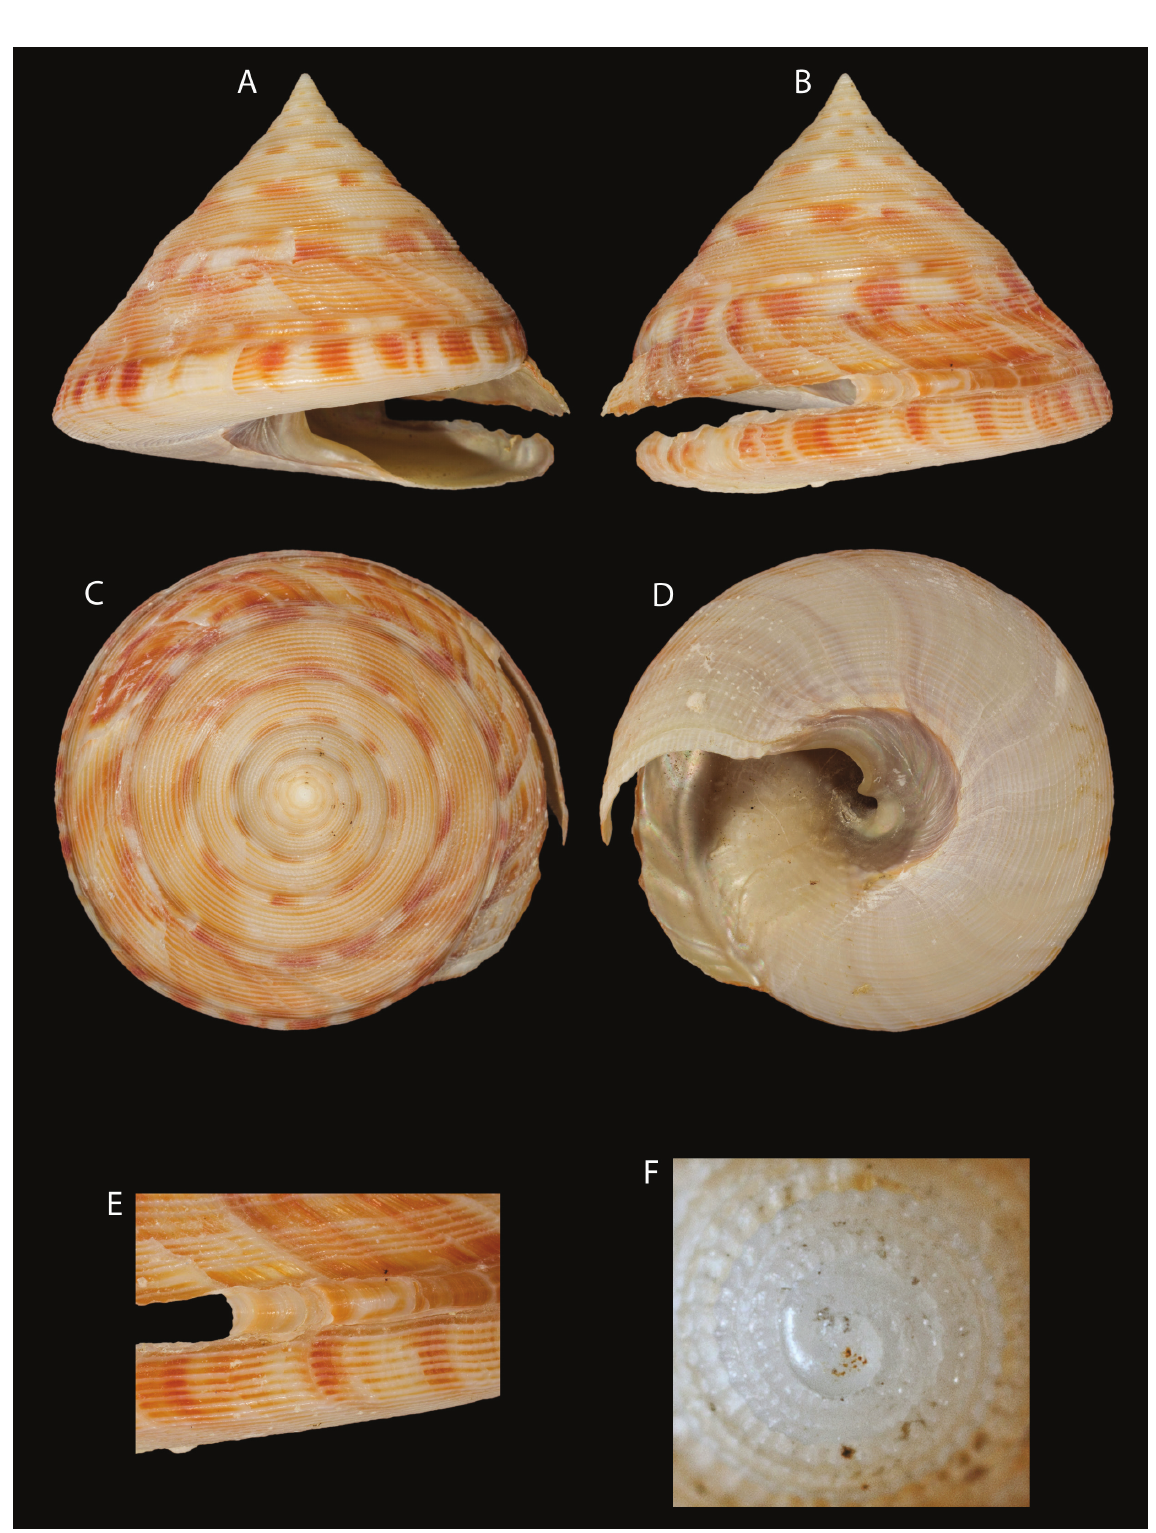
Fig. 5. Perotrochus pseudogranulosus sp. nov., Mnhn-iM-2009-7495, holotype (h = 54.3 mm). A–D . teleoconch. E . slit. F .